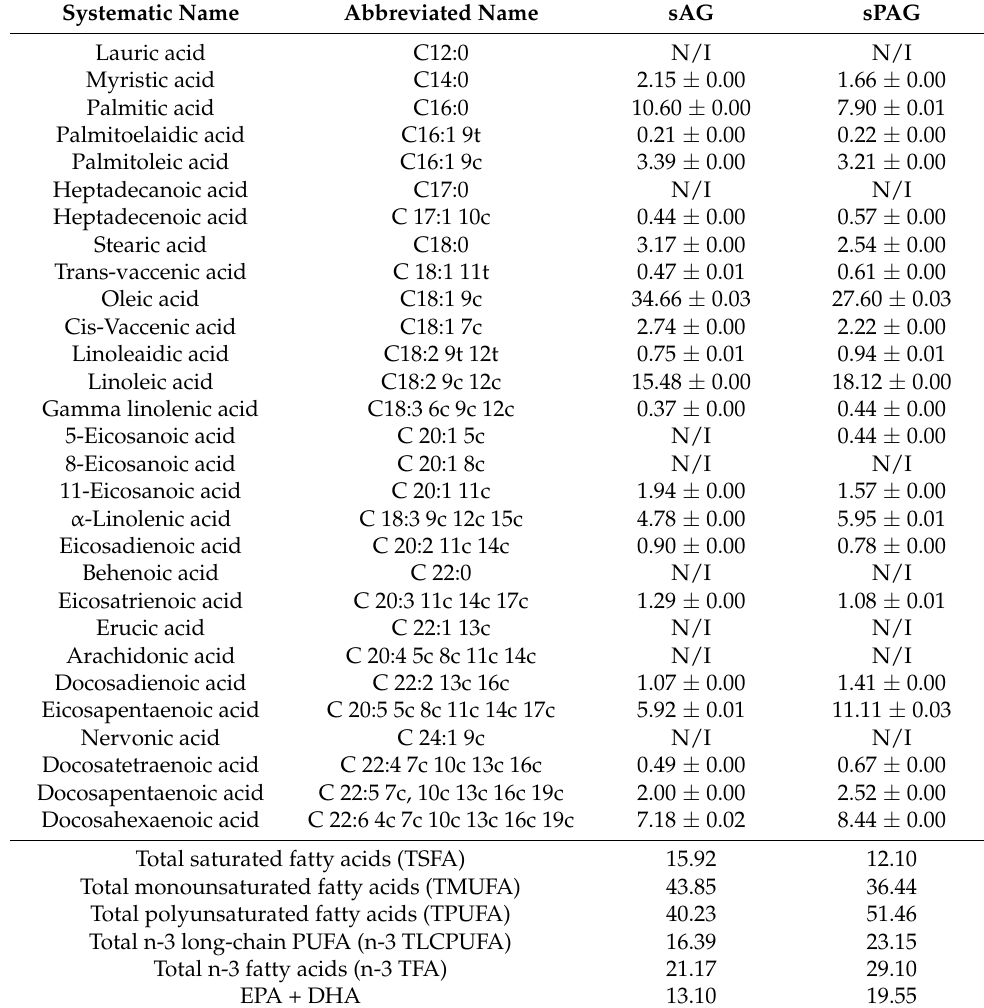
Table 2. Validation of FA composition and quantification of sPAG by GLC (g/100 g